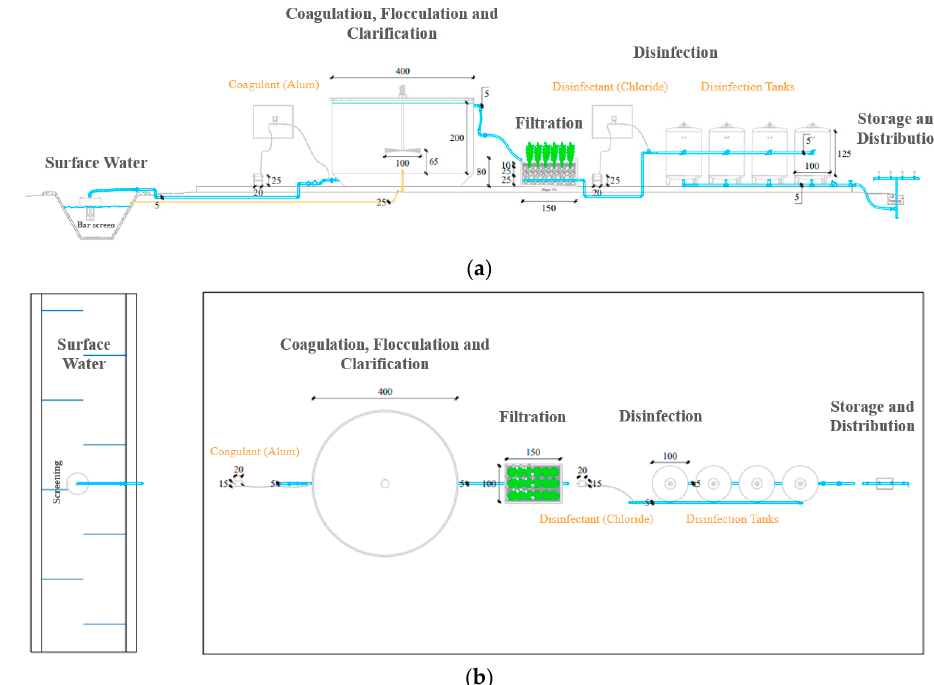
Figure 3. ( a ) Side view and ( b ) top view of the conceptual design of DWTP (all dimensions are expressed in